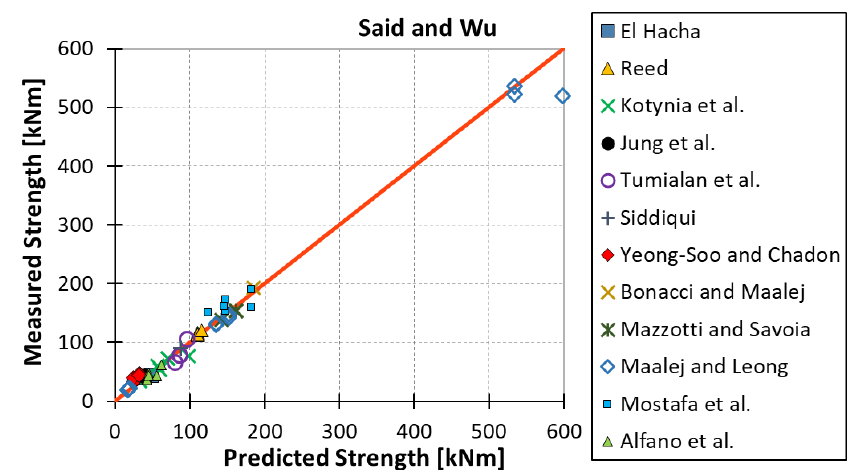
Figure 7. Measured flexural strength versus Seracino et al. model prediction.